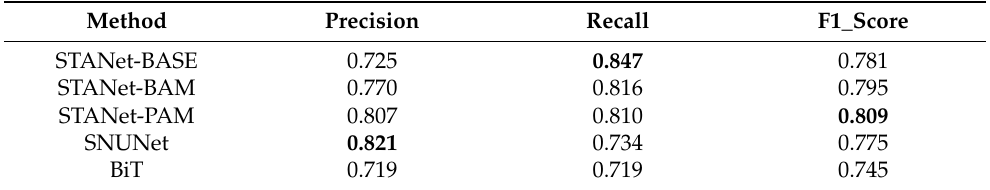
Table 1. The precision, recall, and F1 score of the STANet-BASE, STANet-BAM, STANet-PAM, SNUNet, and BiT. The bold font demonstrates that the value of the corresponding metric is the best.